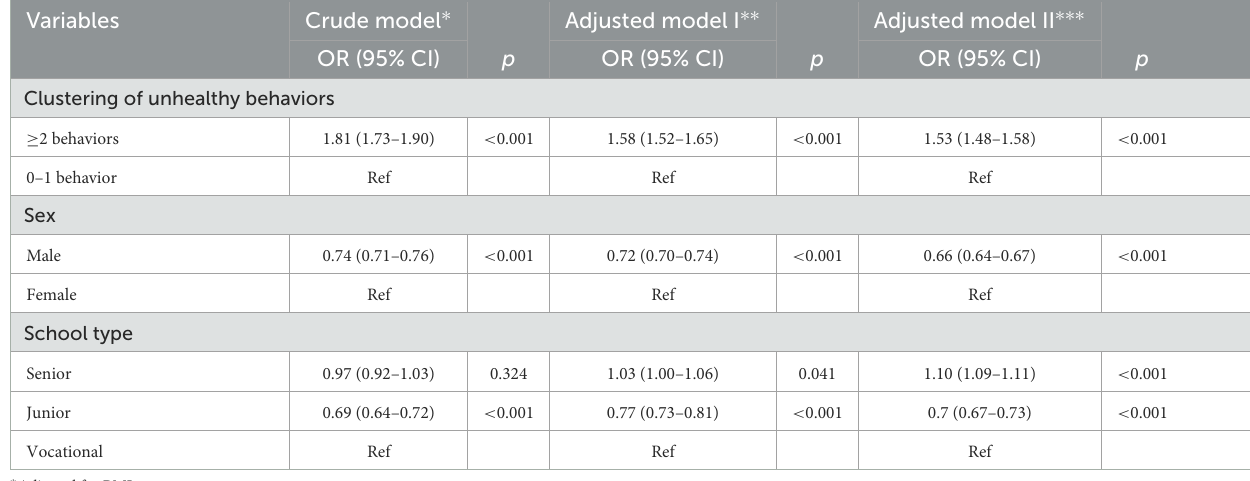
TABLE 2 Association with depressive symptoms across clustering of unhealthy behaviors, sex and school type. Variables